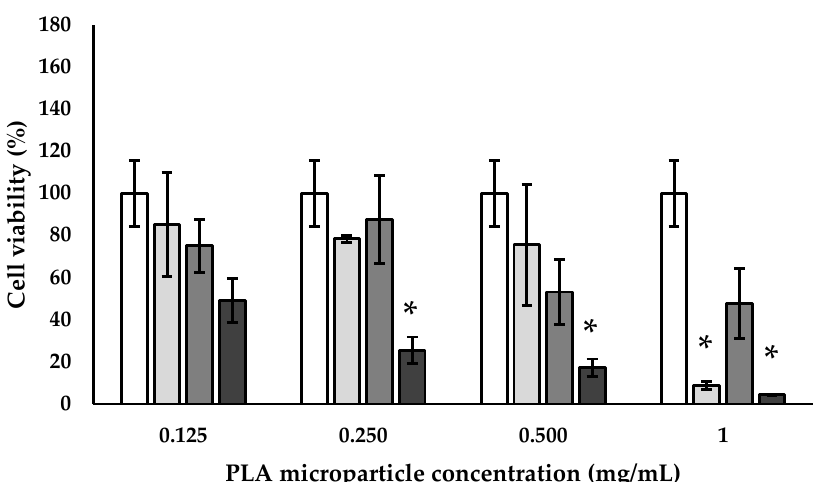
Figure 10. Cell viability of endothelial cells grown for ( A ) 24, ( B ) 48, and ( C ) 72 h in the presence of PLA MPs, * p < 0.05 (with respect to the control using ANOVA with Tukey’s HSD post hoc multiple comparison test). PLA: poly(lactic acid).